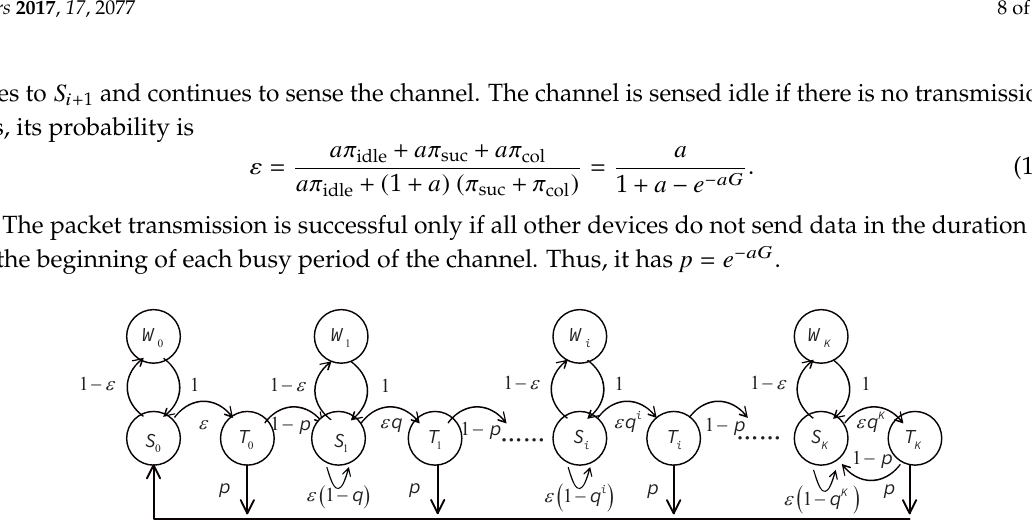
Figure 3. State transition diagram of a packet in the SmBS